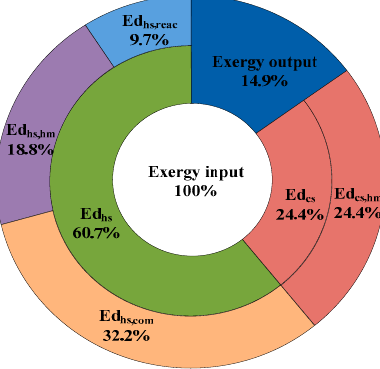
Figure 7. The sources of exergy destruction in the kiln subsystems.